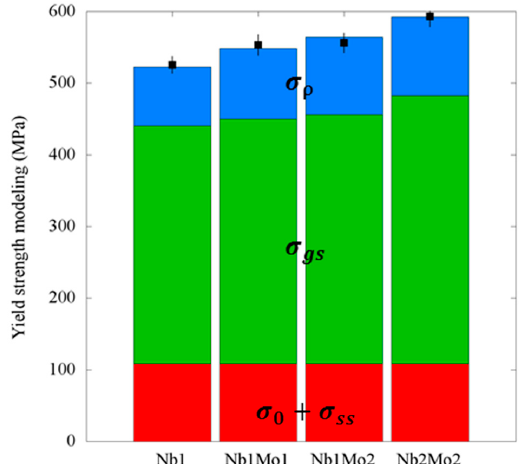
Figure 11. Comparison of the predicted yield stresses with hardness measurements for as-quenched conditions. The square symbols represent the hardness measurements after conversion using the relationship σ = H / κ with the error bar indicating the standard